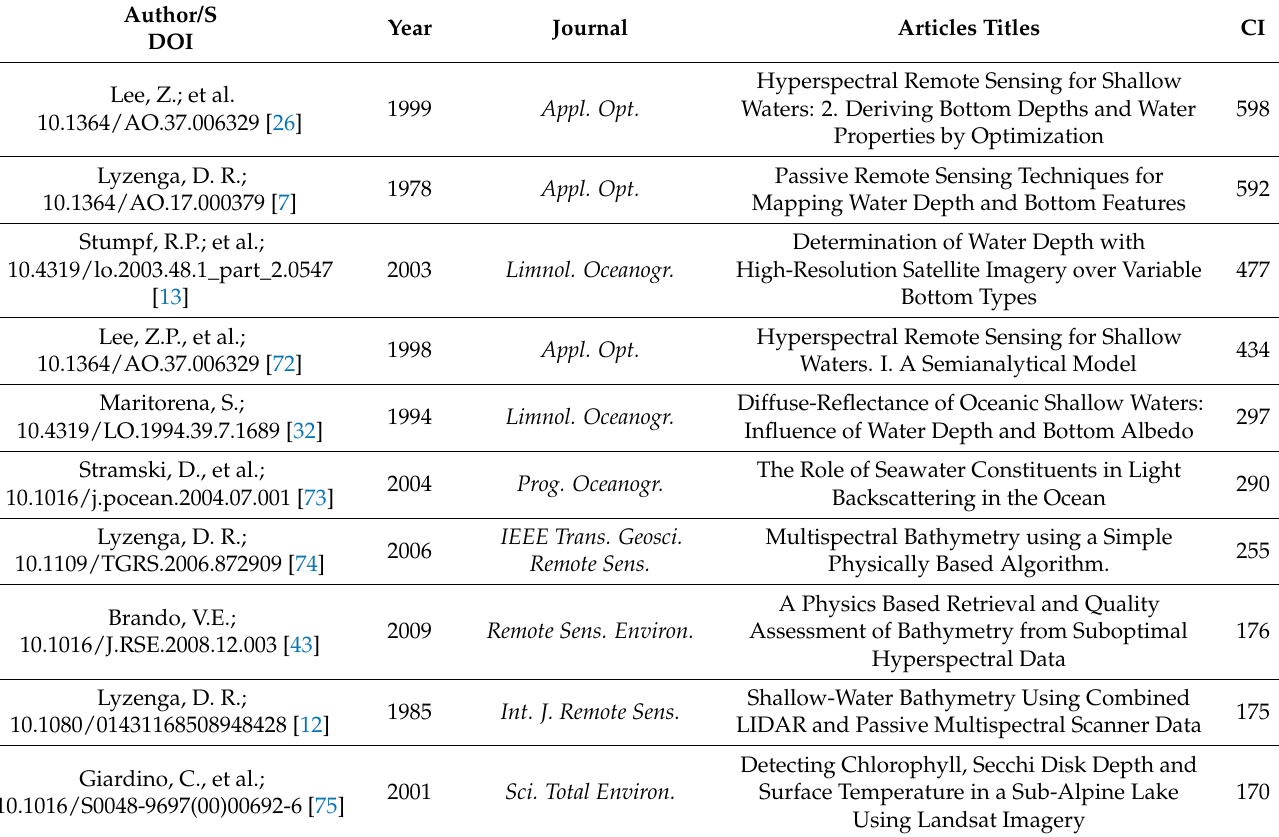
Table 6. Fifteen globally most cited publications—only from the WoSCC